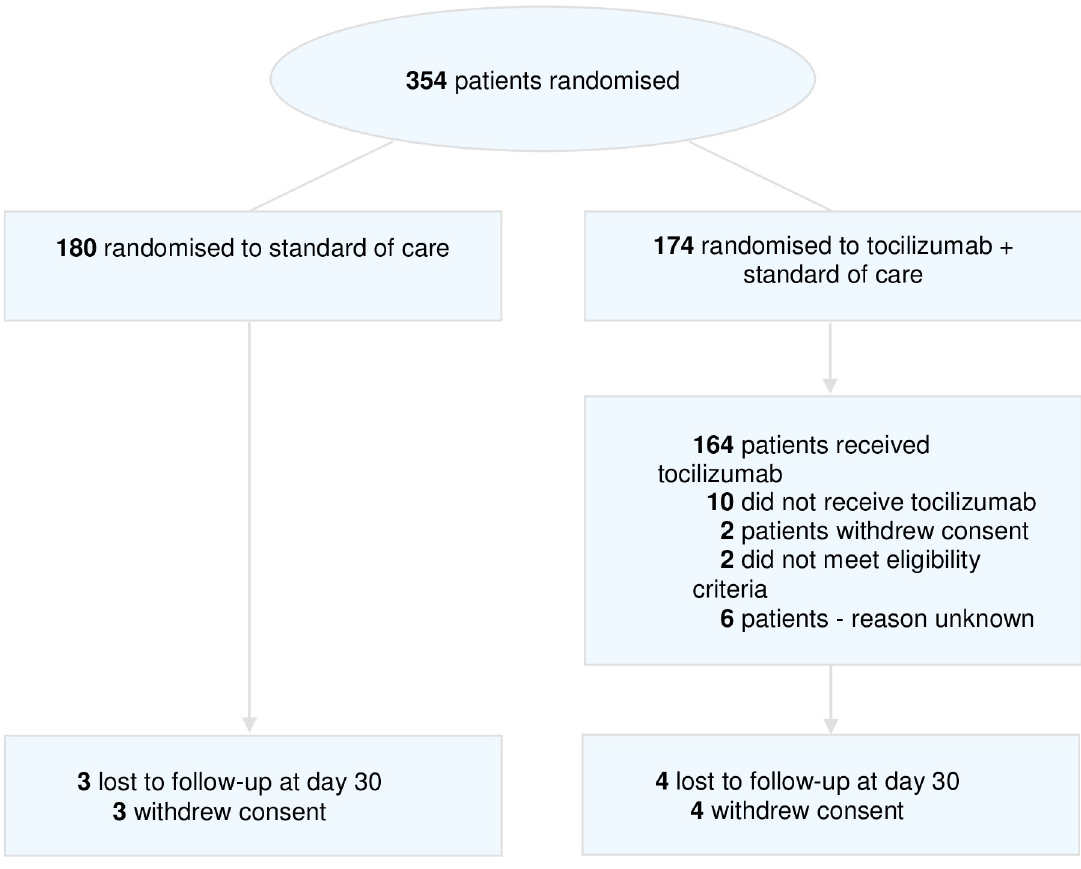
Fig 1. Study flow